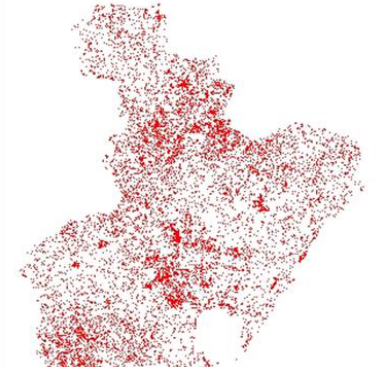
Figure 6 Map of changed and unchanged regions by Two-step